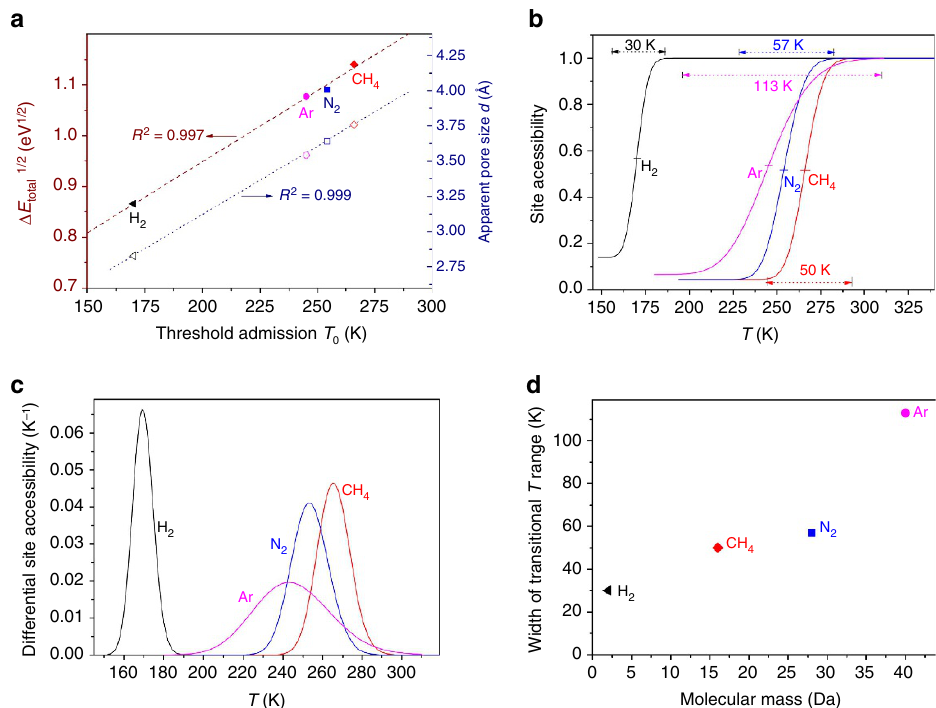
Figure 4 | Physical significance of the temperature-regulated guest admission model parameters. ( a ) Left axis: Linear correlation between the square root of the total energy barrier D E total and the threshold guest admission temperature T 0 , indicating a consistency between the DFTcalculations, framework used to derive the LJM model, and the experimental data. Right axis: linear relationship between T 0 and the apparent pore size of r2 KCHA based on the guest molecule’s kinetic diameter 10,12 . ( b ) Accessibility of adsorption sites as a function of temperature for guest molecules of H 2 , CH 4 , N 2 and Ar as calculated by F 1 (cid:2) E ð Þþ E in equation (6). The lower and upper cut-offs are 0.1 and 99.9% of the accessibility of the internal sites, respectively, and the initial value of the curve represents the fraction of external sites e . ( c ) Corresponding differential site accessibility for the four different guest molecules on r2 KCHA. ( d ) Corresponding width of the transitional temperature range (as characterized by b in the LJM model) for the admission of different guest species, showing heavier molecules tend to have larger distribution